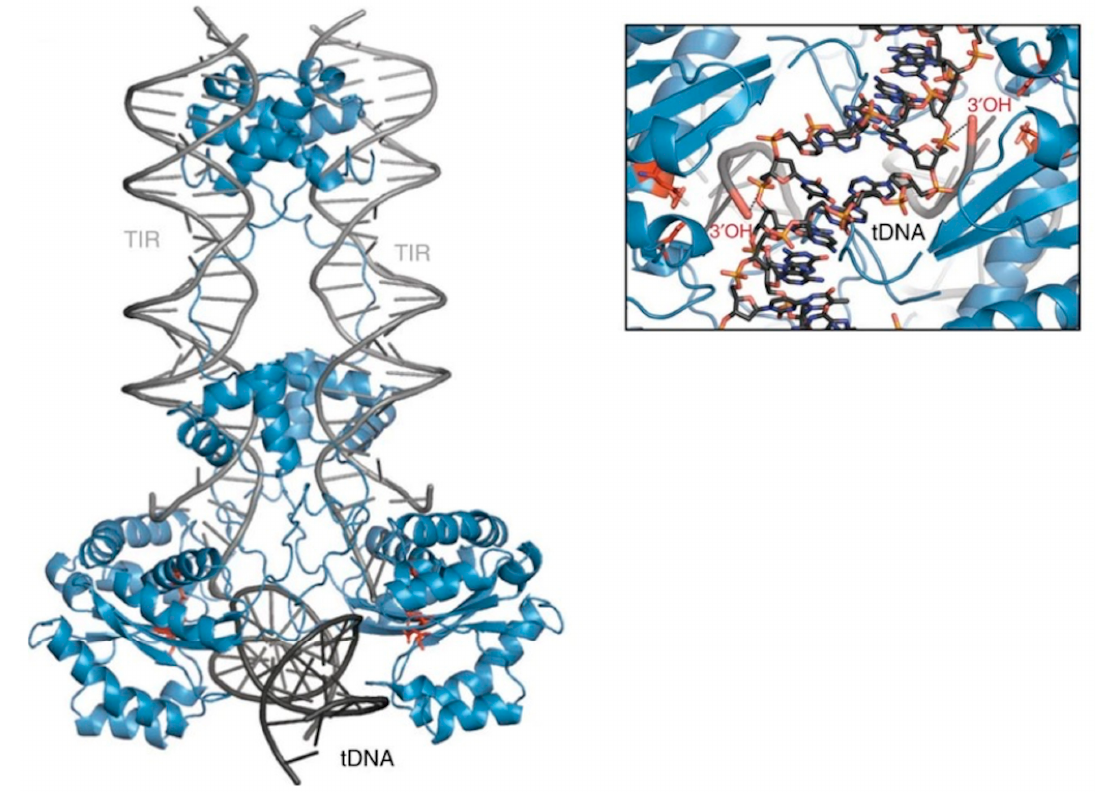
Figure 5. Model of the Sleeping Beauty strand transfer complex. Cartoon representation of the model: SB100X dimer (blue), transposon ends (TIRs, grey), and bent target DNA substrate (tDNA, dark grey). Close up of the target site showing the 3 (cid:48) -OH group attacking the phosphate of the TA target DNA in a staggered way. Reprinted from Nature Communications [23] with permission from the